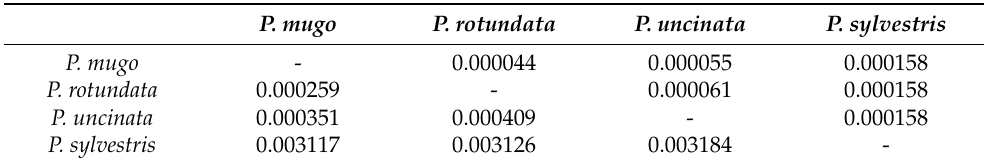
Table 2. Estimates of evolutionary divergence between four Pinus species. The number of base differences per site from between sequences are shown. Standard error estimate(s) are shown above the diagonal and were obtained by a bootstrap procedure (1000 replicates). This analysis involved four nucleotide sequences. All ambiguous positions were removed for each sequence pair (pairwise deletion option). There were a total of 120279 positions in the final dataset. Evolutionary analyses were conducted in MEGA X [48].